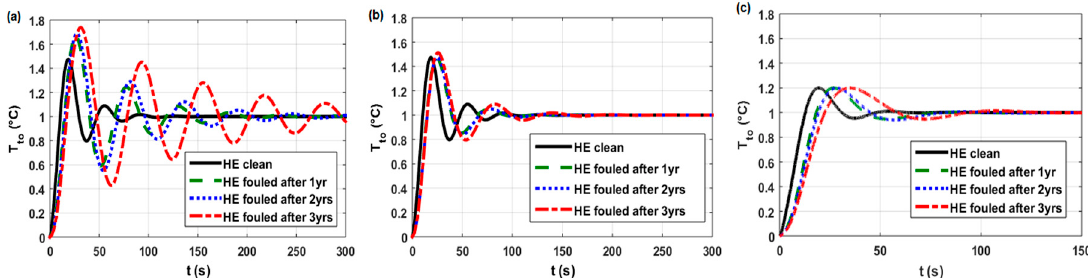
Figure A1. Closed-loop step responses (case in work F) under fouling conditions of the HE E11AB models: without adjustment ( a ) after adjustment ( b ) and after adjustment of optimal ( c ) PID tuning parameters.